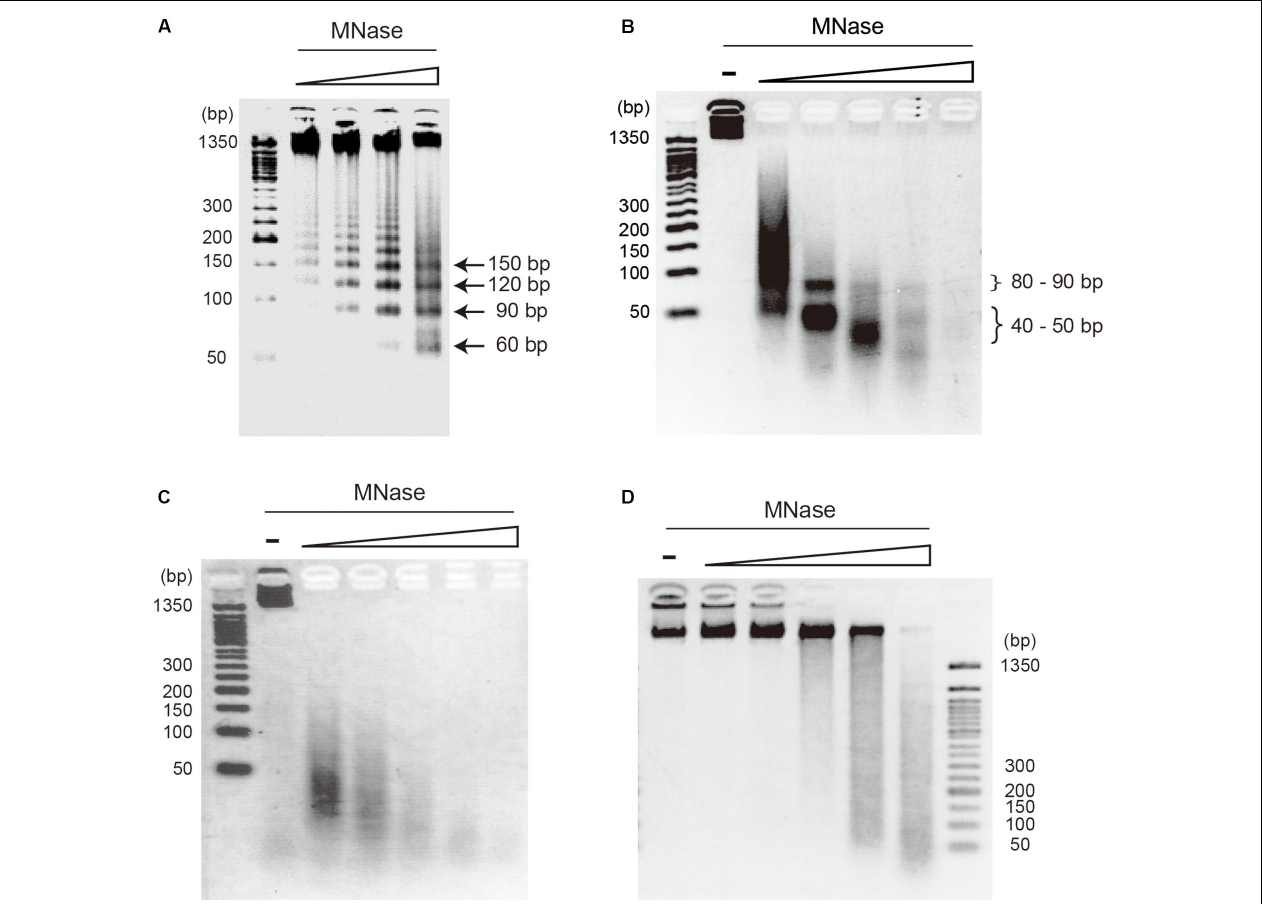
FIGURE 3 | Digestion pattern of archaeal chromosomes treated with micrococcal nuclease (MNase). Purified chromosomes of (A) T. kodakarensis , (B) T. acidophilum , (C) P. calidifontis , and (D) S. solfataricus were digested with increasing concentrations of MNase and separated on 2.5% agarose gels in 1X TBE. The accumulation of DNA of particular sizes was observed with T. kodakarensis (arrows) and T. acidophilum (curly brackets) but not with P. calidifontis and S. solfataricus chromosomes. MNase concentration was 0.3, 1, 3, 10 U MNase in 100 µ l reaction (A) or 0, 0.3, 1, 3, 10, and 30 U MNase in 100 µ l reaction (B–D)